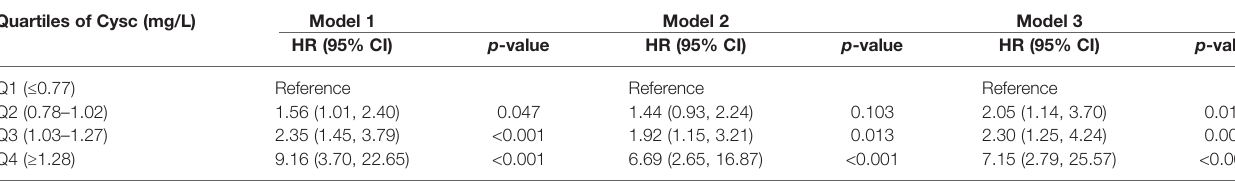
TABLE 2 | Cox regression results of incidence of DKD for quartiles of baseline serum Cysc. Quartiles of Cysc (mg/L)